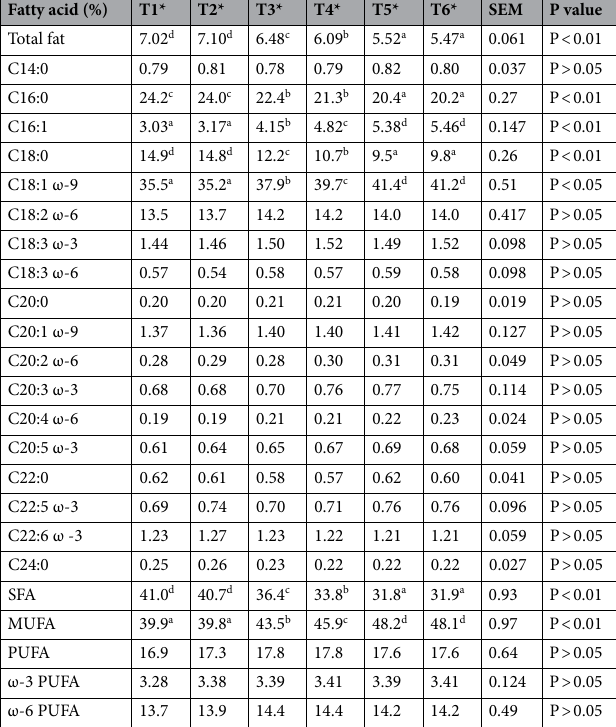
Table 2. Effect of dietary supplementation of Bifidobacterium bifidum (BFD) and Mannan-oligosaccharides (MOS) on fatty acid profile of broiler chicken thigh muscle (n = 6 × 2). *T1 (no BFD/MOS/BMD), T2 (20 mg BMD/kg diet), T3 (0.1% MOS + 10 6 cfu BFD/g feed), T4 (0.1% MOS + 10 7 cfu BFD/g feed), T5 (0.2% MOS + 10 6 cfuB FD/g feed), T6 (0.2% MOS + 10 7 cfu BFD/g feed). BMD Bacitracin Methylene Disalicylate, SFA Saturated fatty acids, MUFA Monounsaturated fatty acids, PUFA Polyunsaturated fatty acids, SEM Standard error of mean. Mean values bearing the same superscripts in a row do not differ significantly.